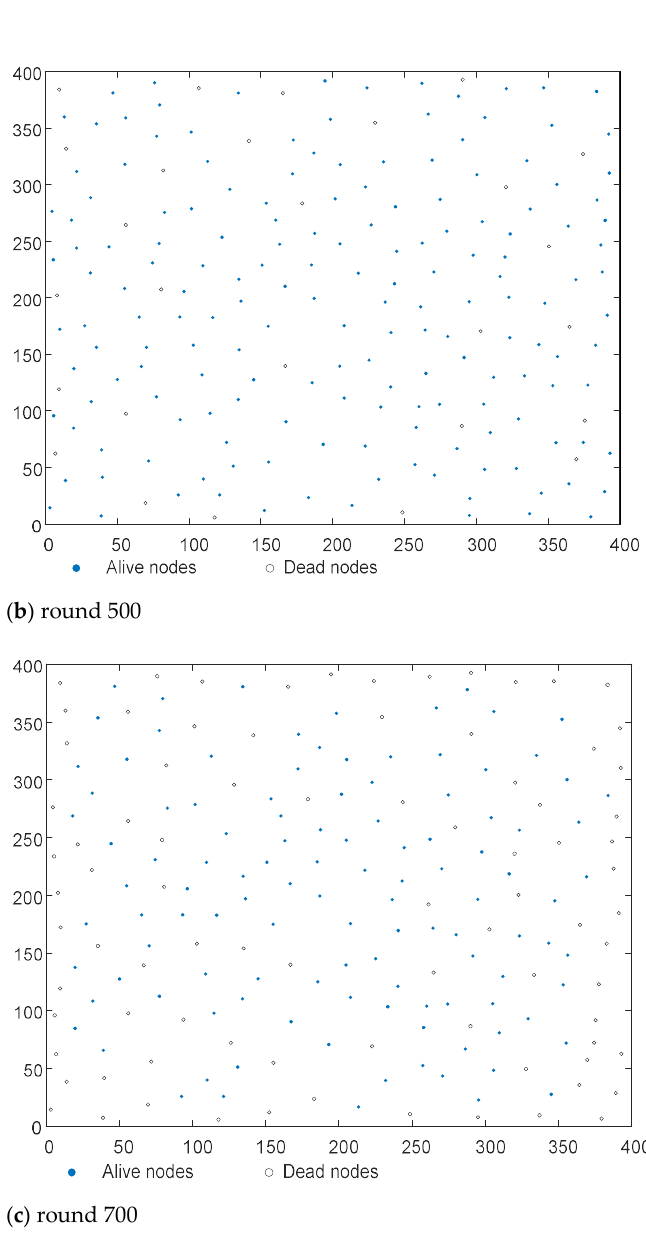
Figure 4. Node distribution of HAR-NP in different rounds.